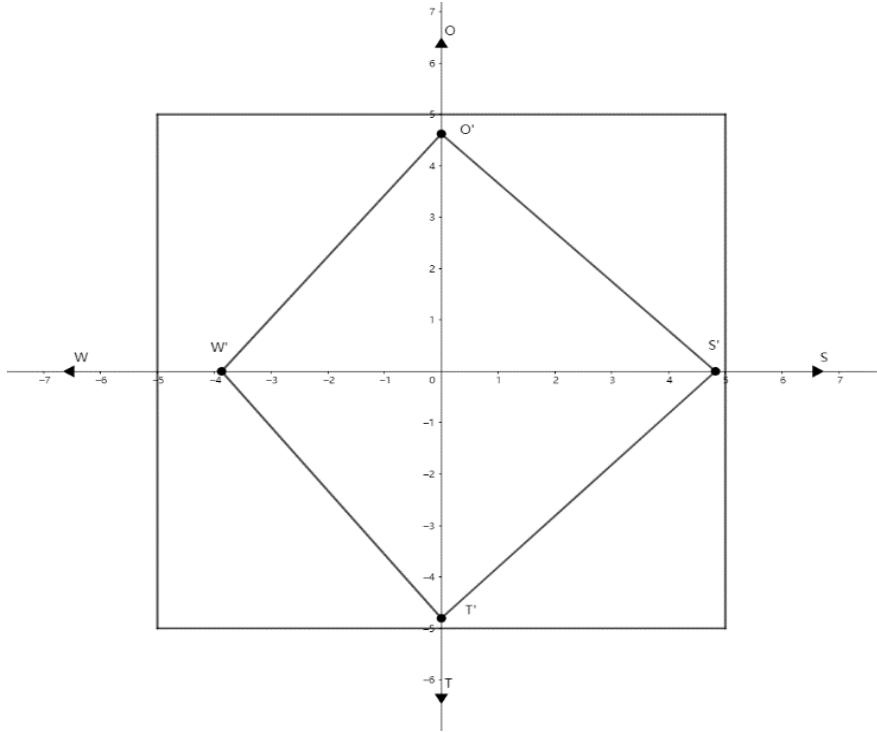
Figure 3. The SWOT strategy quadrilateral.